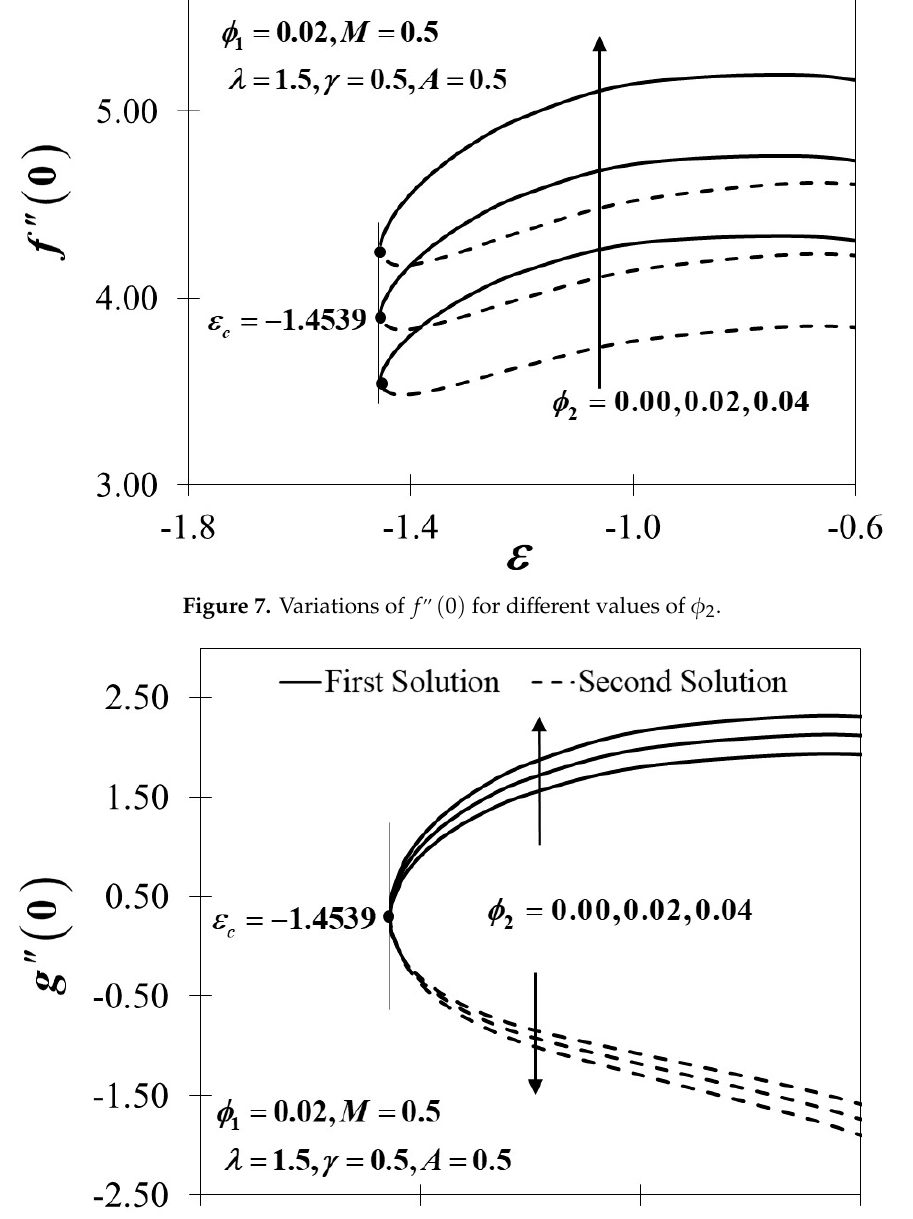
Figure 8. Variations of g (cid:48)(cid:48) ( 0 ) for di ff erent values of φ 2 .